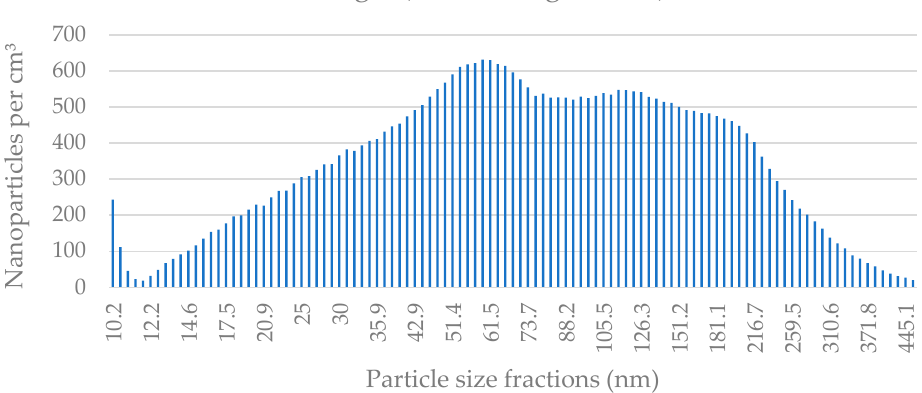
Figure A17. The average nanoparticle concentration in each size fraction in Building 9 during a one- week measurement period during the heating season. Figure A18. The average nanoparticle concentration in each size fraction in Building 9 during a one- week measurement period during the nonheating season.